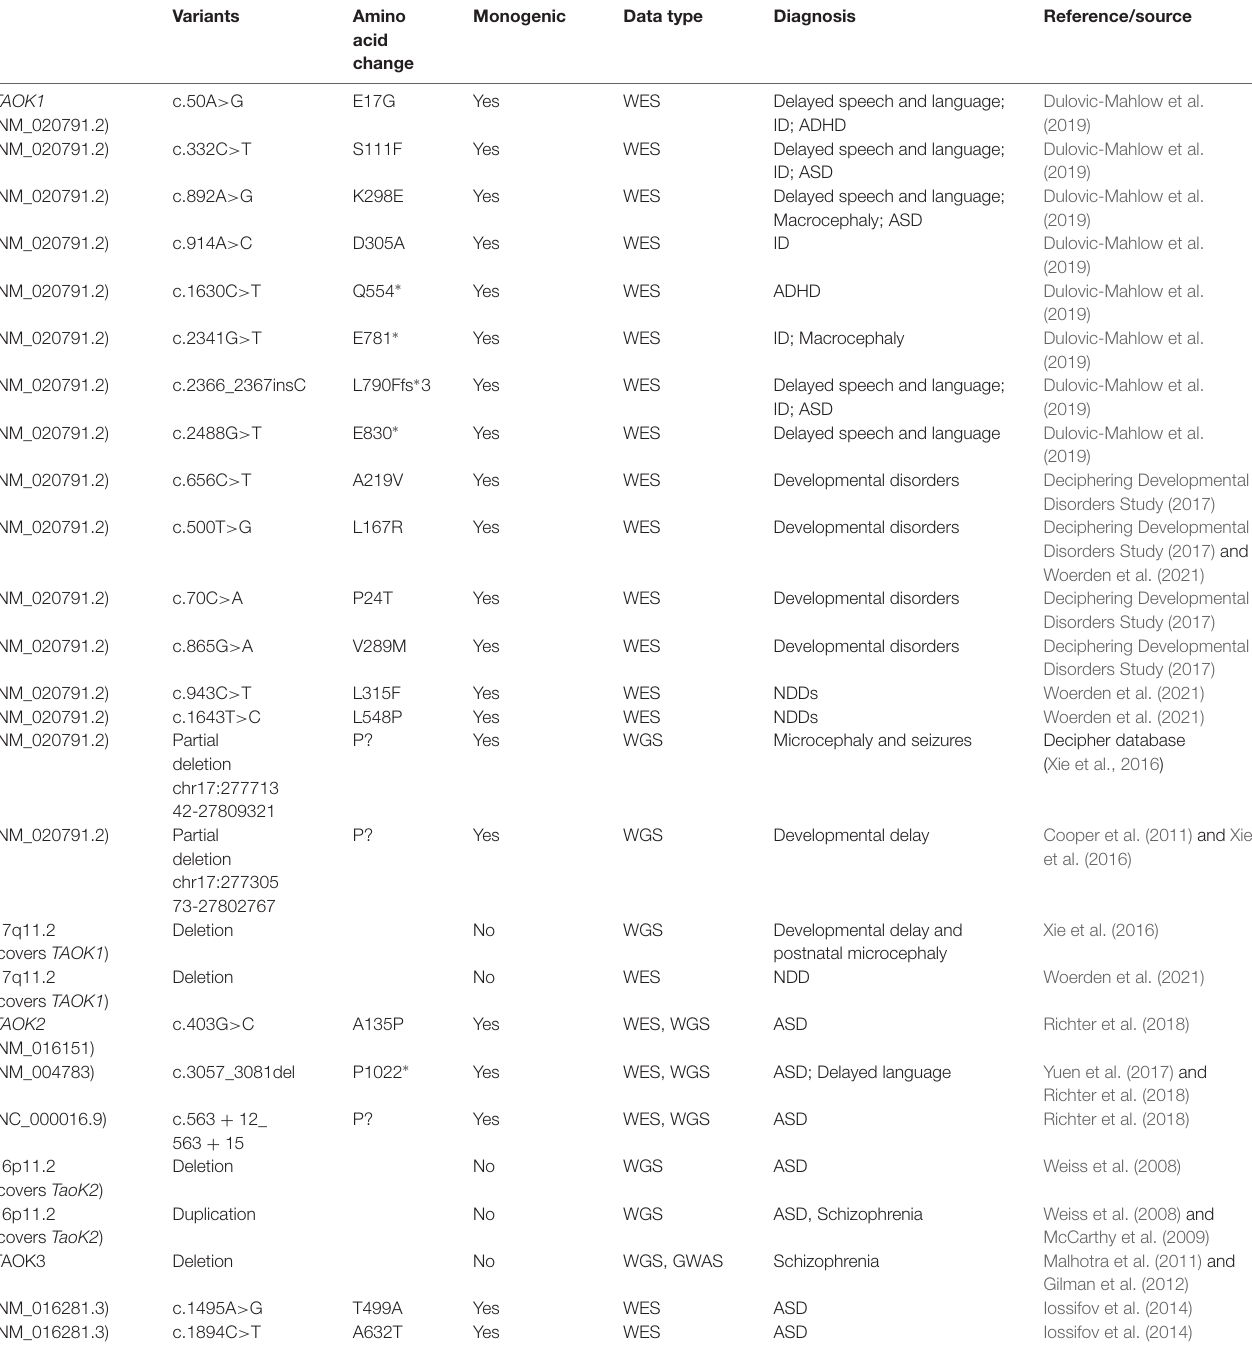
TABLE 1 | A selected list of de novo mutations between thousand and one (TAO) kinases and neurodevelopmental disorders (NDDs).